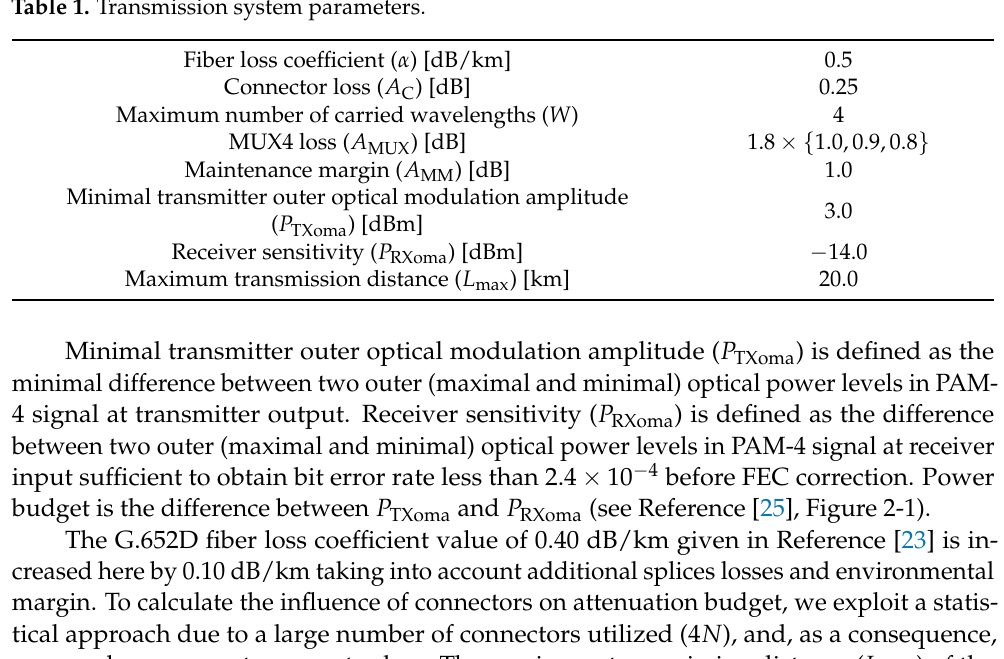
Table 1. Transmission system